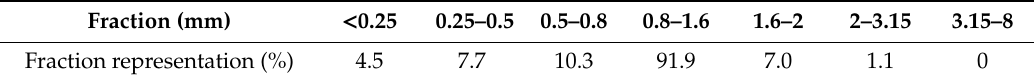
Table 2. Fractions of short-cut woodchips obtained from sieve